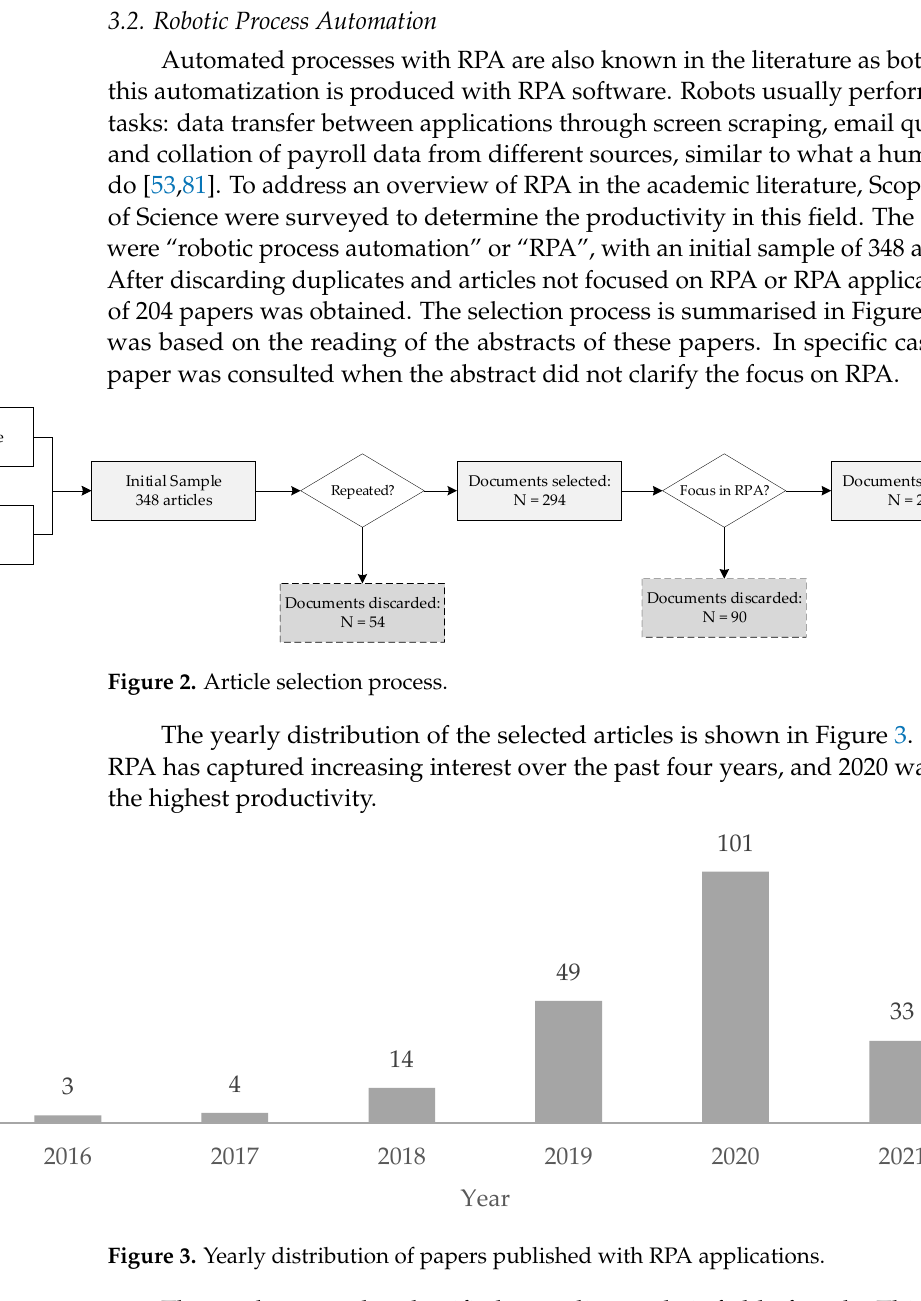
Figure 4. Field of study of the selected papers.